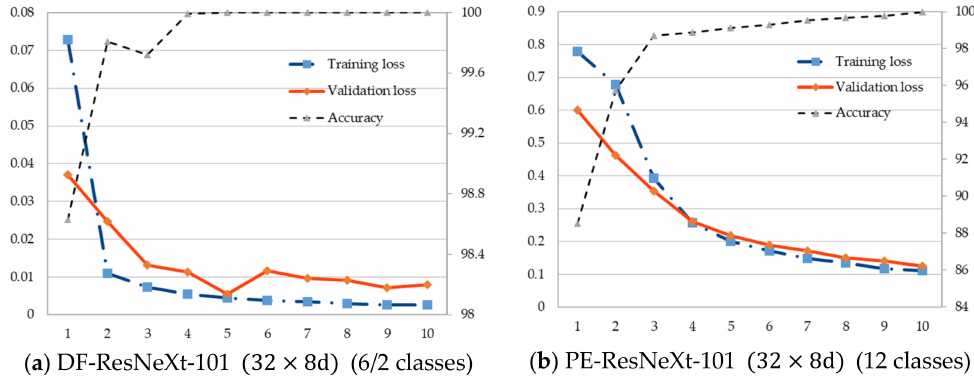
Figure 6. Training, validation loss, and accuracy (%).